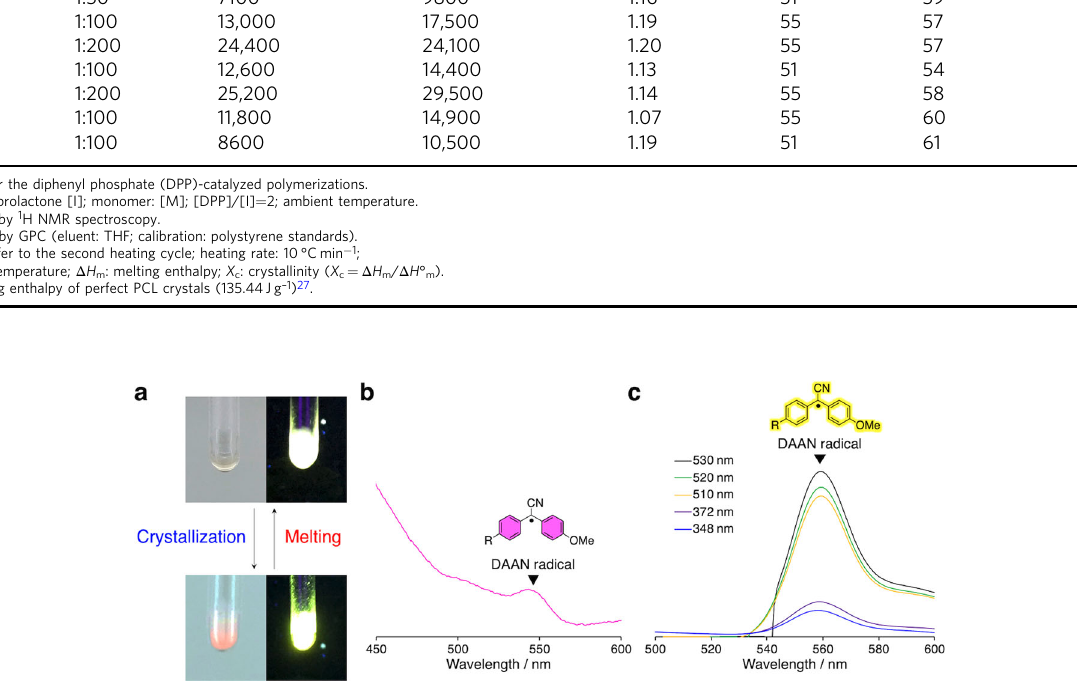
Table 1 Molecular weight and thermal properties of L-PCL, S-PCL, C 1 -PCL, and C 2 -PCL Molecular weight and thermal properties of the synthesized linear and star-shaped polycaprolactones that contain a mechanochromophore or a control moiety. Structure